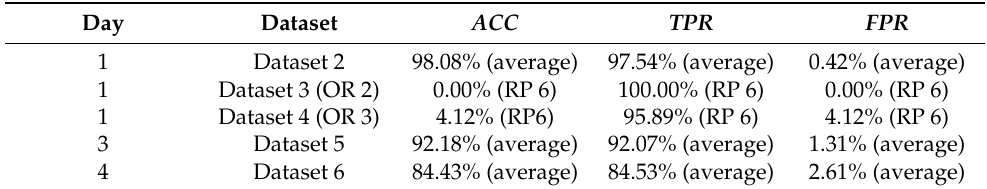
Figure 8. Confusion matrix of different RPs (Lab) with Dataset 3 against AP 1. Table 1. Summary of evaluation metrics across different time periods and orientations on different RPs using AP